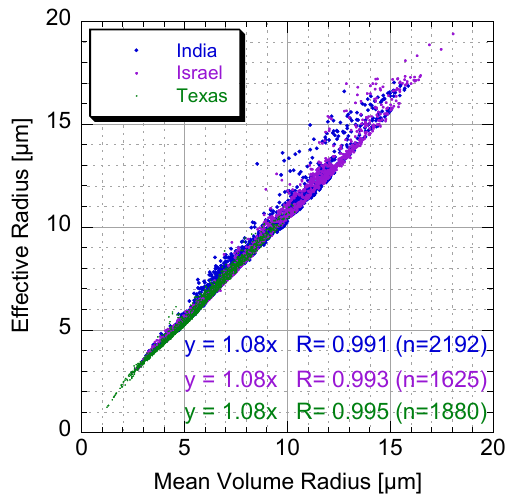
Fig. 5. The cloud droplet effective radius, R e , versus the droplet mean volume radius, R v , for over 5800 1Hz-averaged droplet size distributions mainly in convective clouds. The color-coding rep- resents different field campaigns and location data: purple for the Israeli rain enhancement program; blue for CAIPEEX-1 in India; and green for SPECTRA (The Southern Plains Experiment in Cloud seeding of Thunderstorms for Rainfall Augmentation; Axisa et al., 2005). The number of measurements that were used to calculate the linear best-fit for each location is denoted by “ n ” in the lower-right part of the figure. Notice that R e is larger than R v on average by 8% regardless of the location, and that the linear correlation coeffi- cient is greater than 0.99. This means that for practical uses R e may be used instead of R v for the derivation of N a (see Eq.